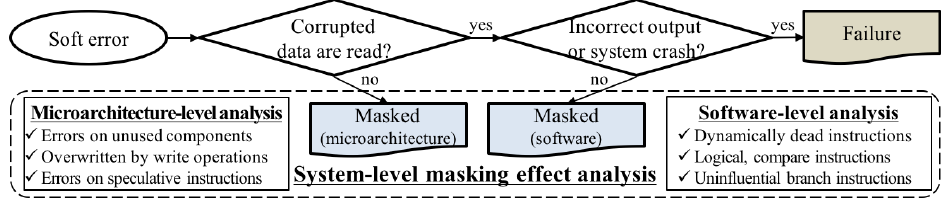
Figure 2. Classification when soft error occurs in microarchitectural